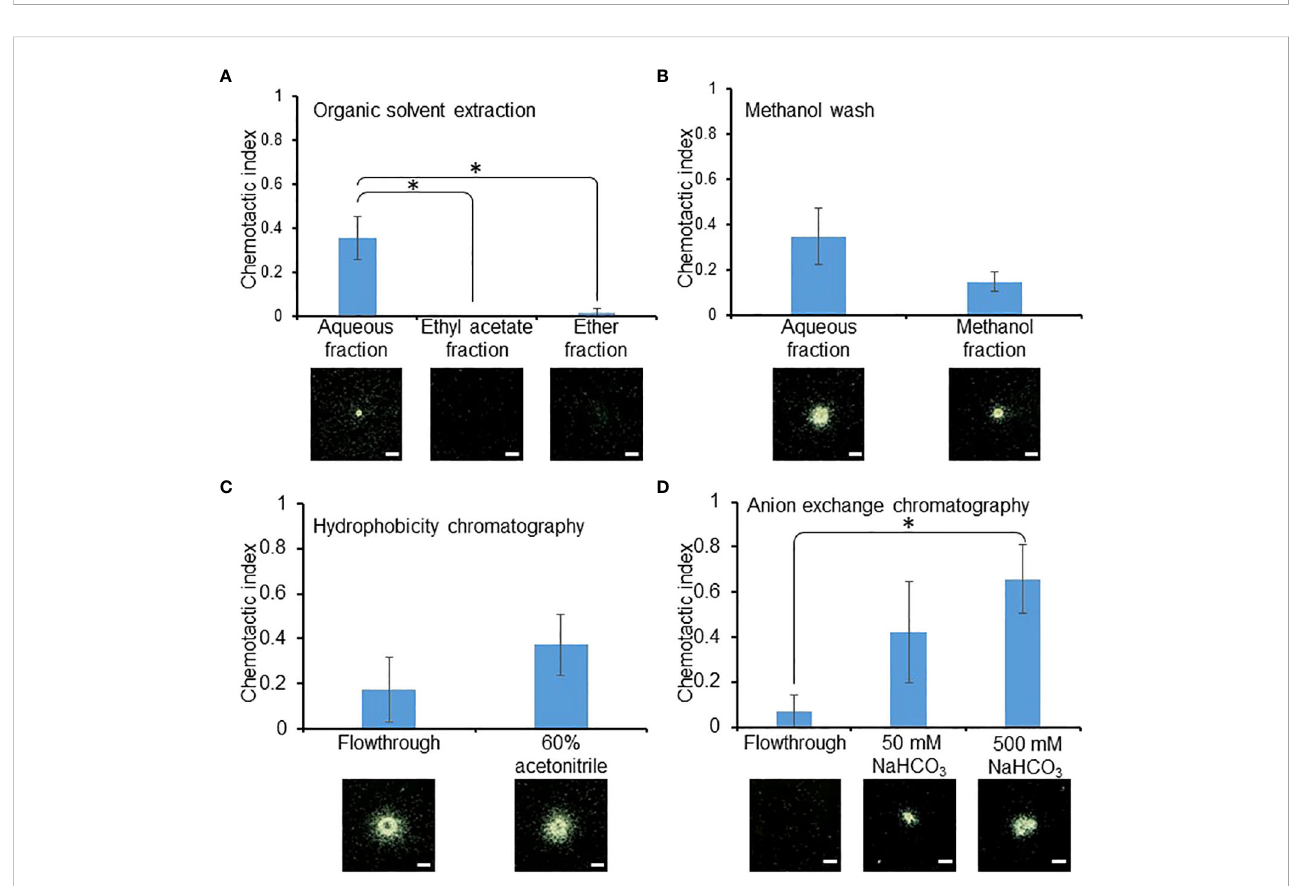
FIGURE 3 RKN attraction activities were maintained through enrichment. RKN chemotactic indexes of the intermediate fractions during attractant puri fi cation from SR media supernatant, during organic solvent extraction (A) , methanol wash (B) , hydrophobicity chromatography (C) , and anion exchange chromatography (D) . Averages from n = 3 ± SD are shown. * denotes signi fi cant difference between the indicated samples. (student ’ s T-test, P<0.05). Bottom panels show representative RKN in vitro behavior; scale bars = 1